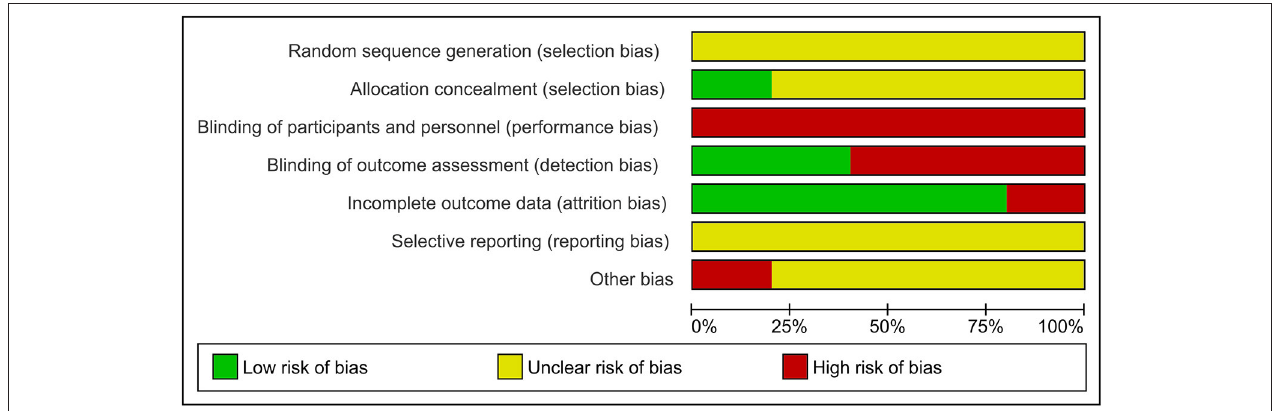
FIGURE 4 | Risk of bias graph for a secondary outcome: the impact of whole, fresh fruit consumption on energy intake in RCTs. Bars illustrate the proportion of trials that received a particular risk of bias score in each risk of bias